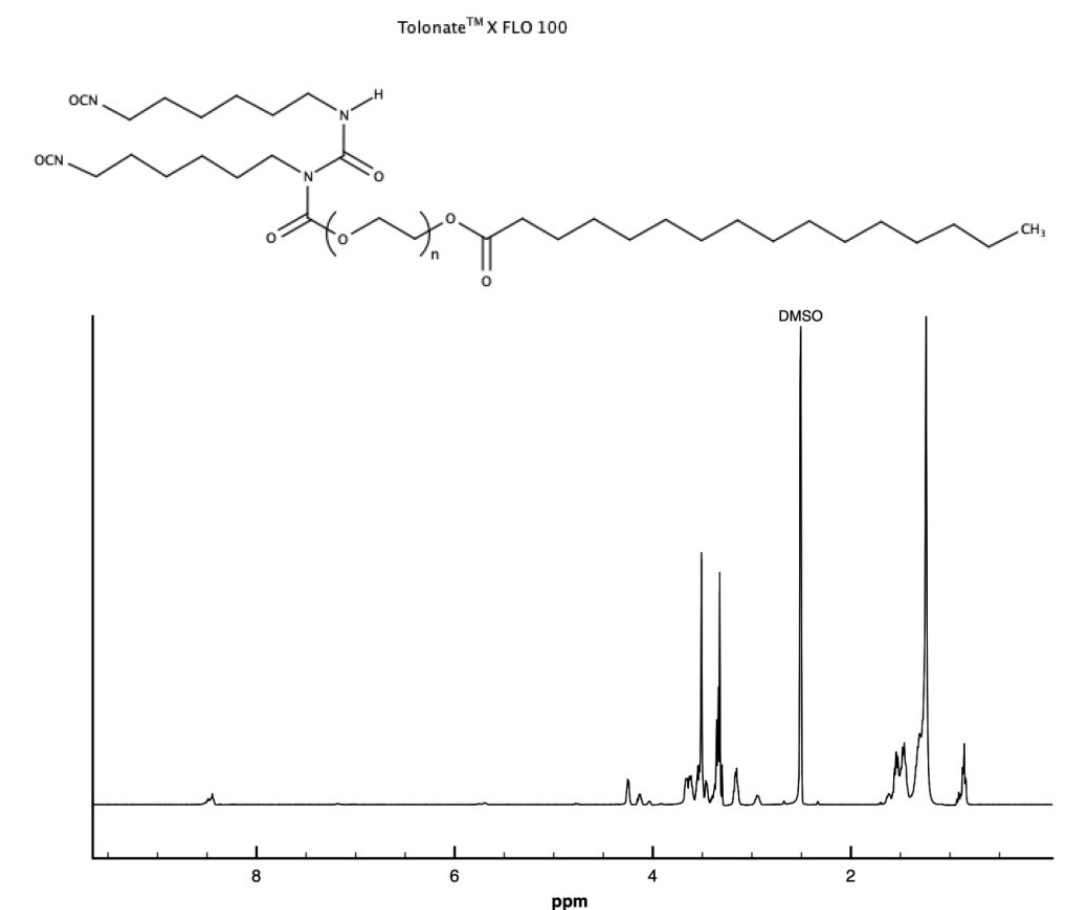
Figure 3. 1 H NMR spectra of Tolonate X FLO 100 sample.